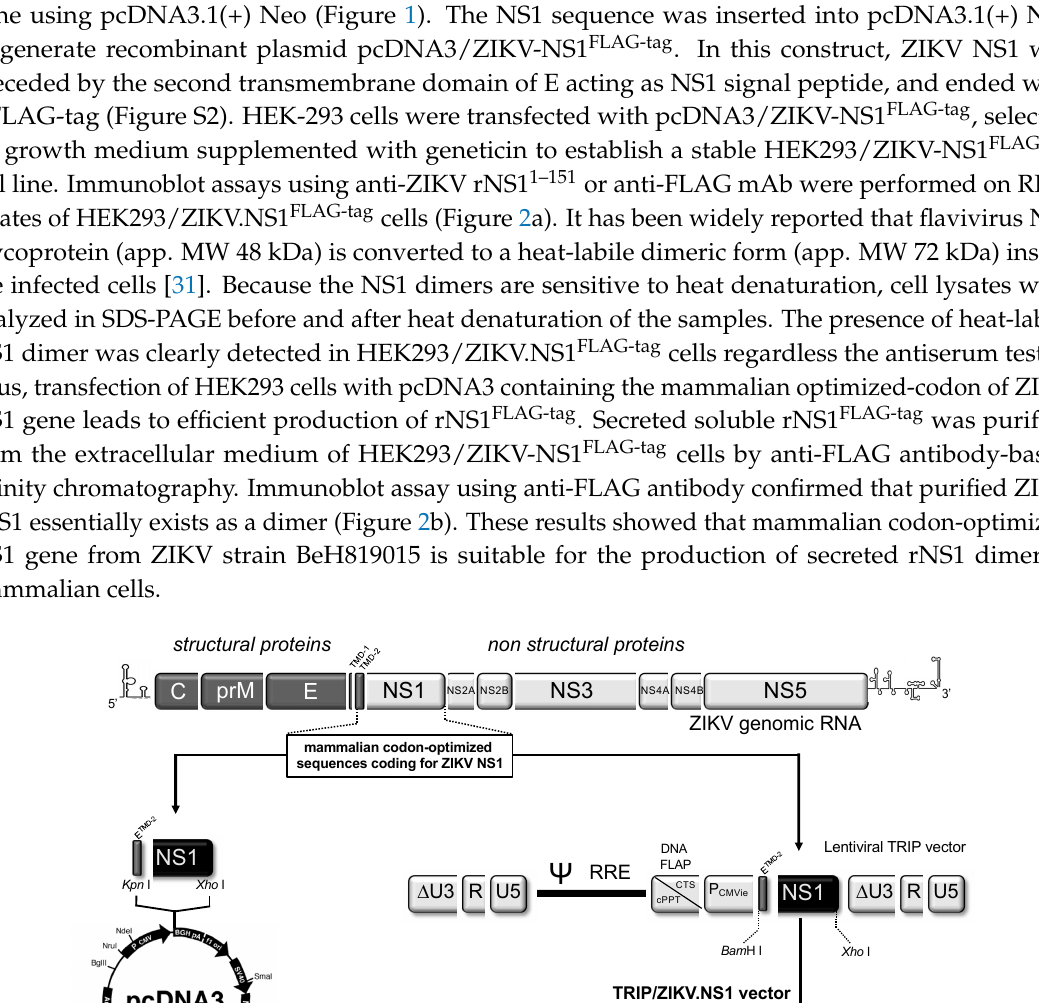
( a ) ( b ) Figure 2. Expression of recombinant ZIKV NS1 protein in HEK-293 cells stably transfected with a plasmid vector.